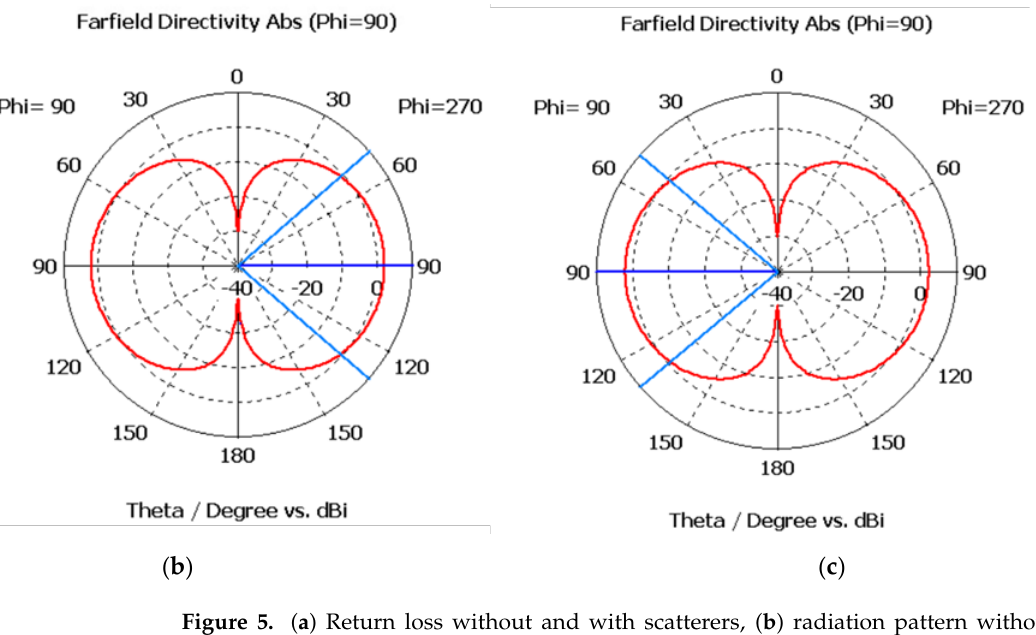
Figure 5. ( a ) Return loss without and with scatterers, ( b ) radiation pattern without scatterers, ( c ) radiation pattern with scatterers.